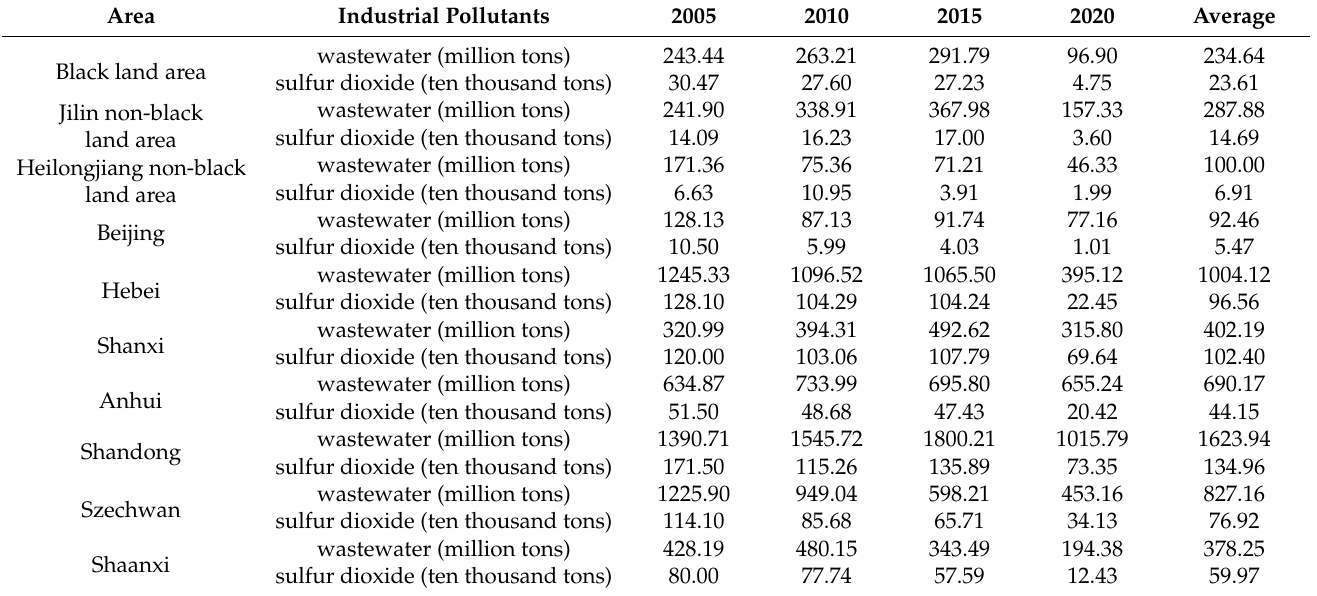
Figure 2. Typical black land county-level and national provincial regions. Table 1. Industrial pollution emission data for northeast black land area and some